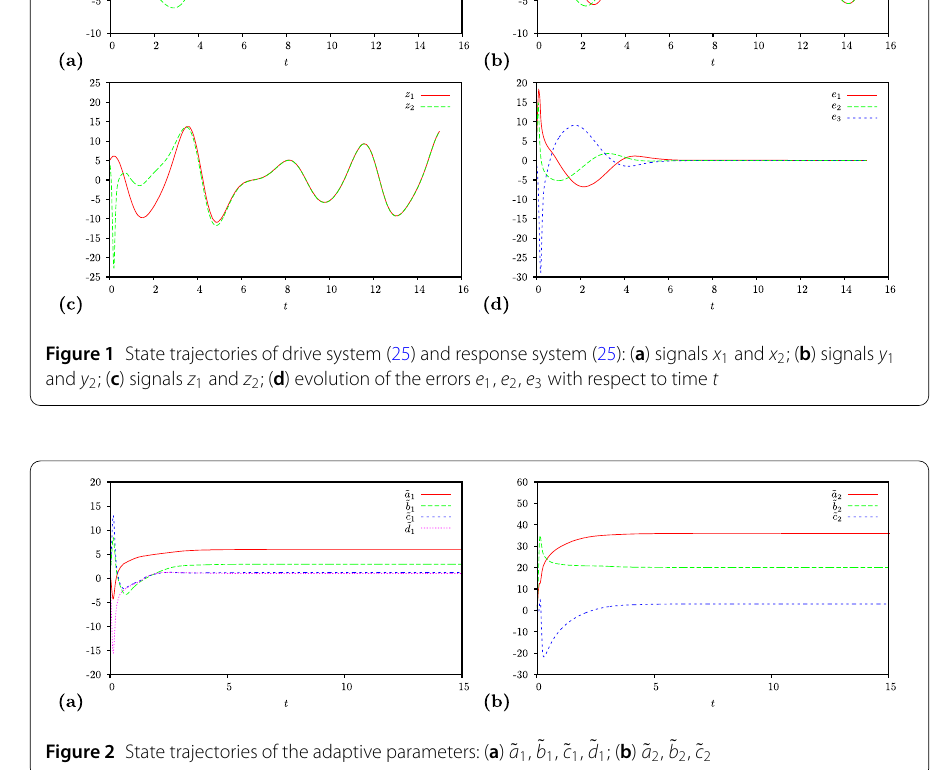
c 1 = 1.2 and d 1 := 1; and a 2 = 36, b 2 = 20, c 2 = 3. The initial values of the